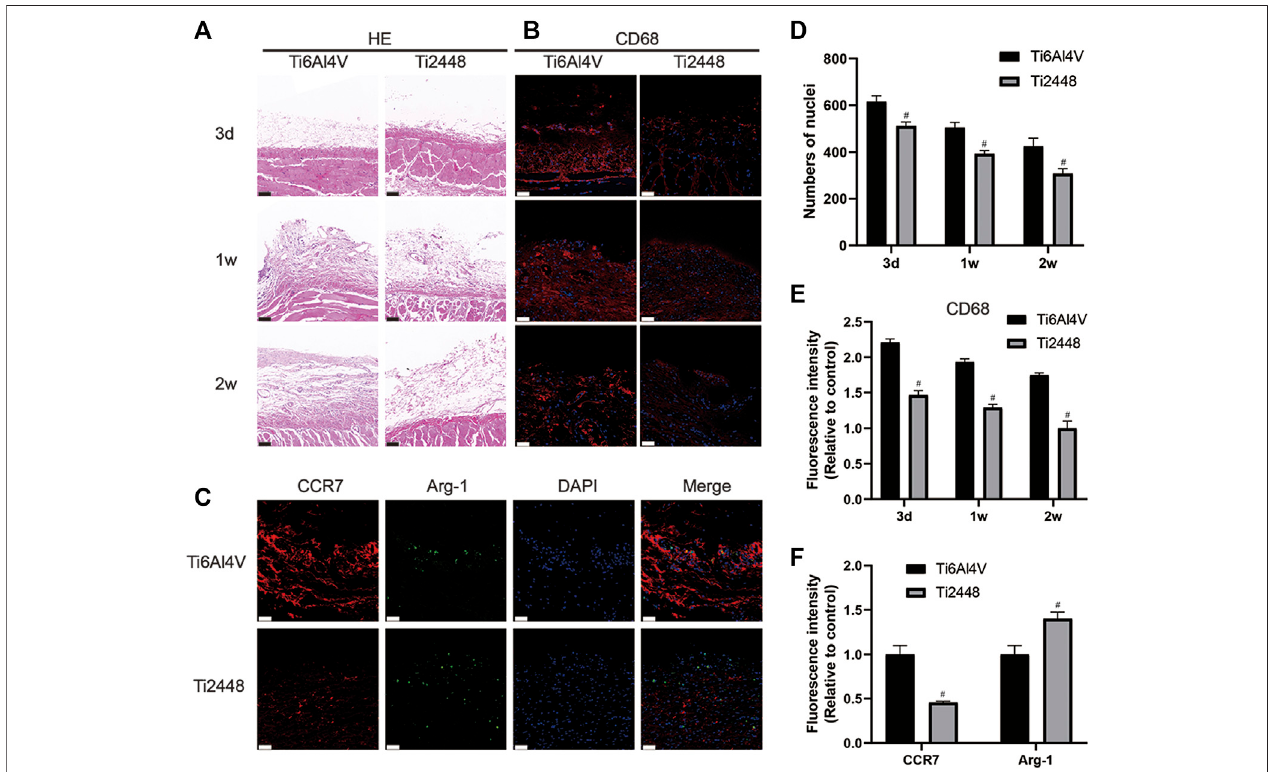
FIGURE 6 | In fl ammatory response to scaffolds evaluated and analysed in subcutaneous tissue. HE staining of skin specimens at 3 days, 1 and 2 weeks after implantation. Scale bar (cid:2) 100 µm (A) . Evaluation of in fl ammation by immuno fl uorescence staining for CD68 in the skin. Scale bar (cid:2) 50 µm (B) . Immuno fl uorescence staining for CCR7 (marker for M1 macrophages) and Arg-1 (marker for M2 macrophages) in the skin at 1 week. Scale bar (cid:2) 50 µm (C) . Quantitative analysis of the number of nuclei around the scaffolds (D) . Quantitative analysis of the fl uorescence intensity of CD68 around the scaffolds (E) . Quantitative analysis of the fl uorescence intensity of CCR7 and Arg-1 around the scaffolds (F) . Note: # p ＜ 0.05 compared to Ti2448.